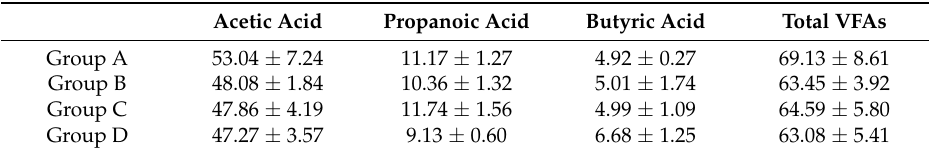
Table 4. Effect of intragastric administration with C. butyricum Sx-01, L. salivarius C-1-3 and a combination thereof on blood excrement Volatile fatty acids (VFAs) concentration of mice (Day 0).